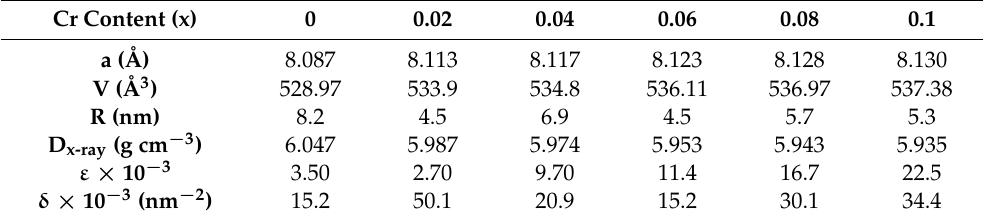
Table 1. Lattice parameter (a), cell volume (V), crystallite size (R), strain ( ε ) and dislocation density ( δ ), for Cr x Co 3 − x O 4 thin film